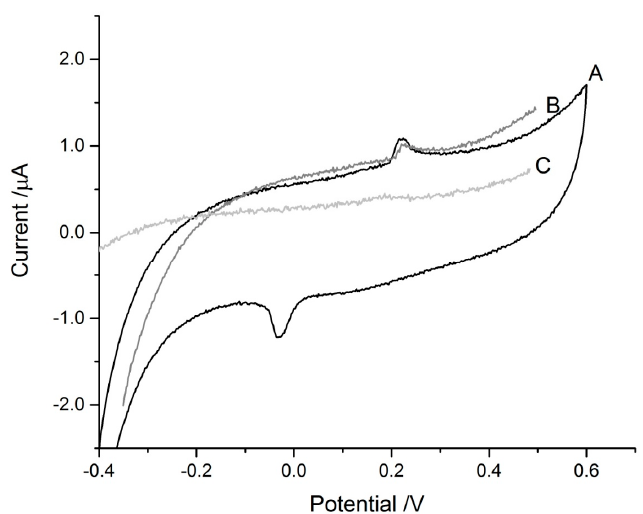
Figure 3. Representative electrochemical measurements of MT-loaded and blank-paper discs on SPCEs with 25 μ L of deionized water added. ( A ) Cyclic voltammetry (CV) scan of MT-adsorbed disc; ( B ) anodic stripping voltammetry (ASV) scan on MT-adsorbed disc; and ( C ) ASV scan of blank paper disc. The ASV and CV scans of the blank paper disc were similar and showed no distinct peaks.